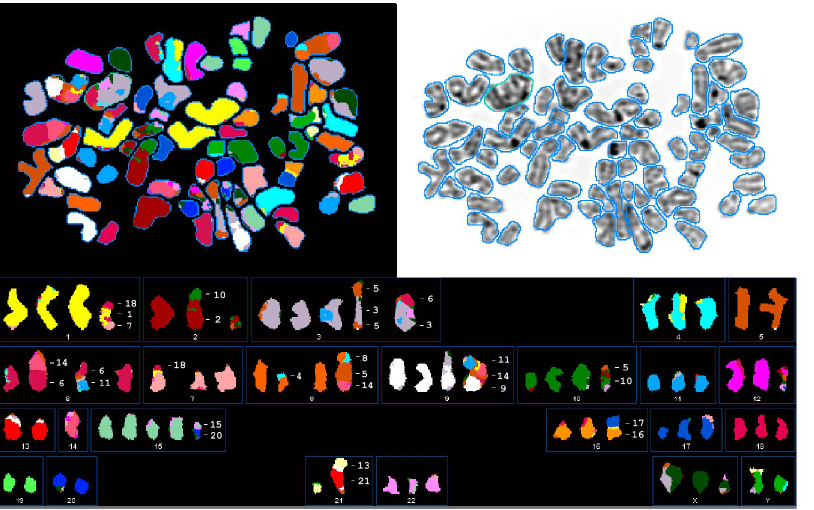
Figure 3. Spectral karyogram (SKY) of the hepatic stellate cell line LX-2. Shown is a representative image of LX-2 cells hybridized with a 24- color SKY probe ( upper left panel ). The chromosomes were counterstained with DAPI ( upper right panel ). The spectral images of hybridized metaphases were acquired using a cytogenetic workstation and grouped with the SkyView software ( lower panel ). Based on this analysis, the karyotype of this LX-2 metaphase is determined to: 73 , 3n + . , XXXYY, ish + der(1)t(1;18)(p11;q21)t(1;7)(q42;p12), der(2)t(2;10)(p11;q11), del(2)(q11), + der(3)t(3;6)(qter;q11), der(3)t(3;5)(p11;q23)t(3;5)(q24;q23)del(5)(q14), 2 5, + del(6)(p11), der(6)t(6;14)(p11;q11), der(6)t(6;11)(q11;q12), der(7)t(7;18)(p11;p11), del(7)(q21), + der(8)t(8;5)(q11;q11)t(5;14)(q31;q23), der(8)t(4;8)(q32;p12), + der(9)t(3;9)(p22;qter)del(9)(p11), der(9)t(9;14)(p12;q11)t(14;11)(q24;q14)del(11)(q12), + der(10)del(10)(p12)del(10)(q23), der(10)t(5;10)(p12;p11), del(11)(p14), der(11)del(11)(p14)- del(11)(q23)x2, der(12)t(12;22)(q13;q12), 2 13, 2 14x2, + i(15)(p10), + der(15)t(15;20)(q15;q11), der(16)t(16;17)(p11;q11), del(17)(p11), 2 19, 2 20, 2 21, der(21)t(21;13)(p11;q11), del(X)(q24), del(X)(q25), del(X)(q21). Please note that the derivative that contains parts of chromosomes 1, 18 and 7 (cf. Figure 1) were also seen in this analysis.